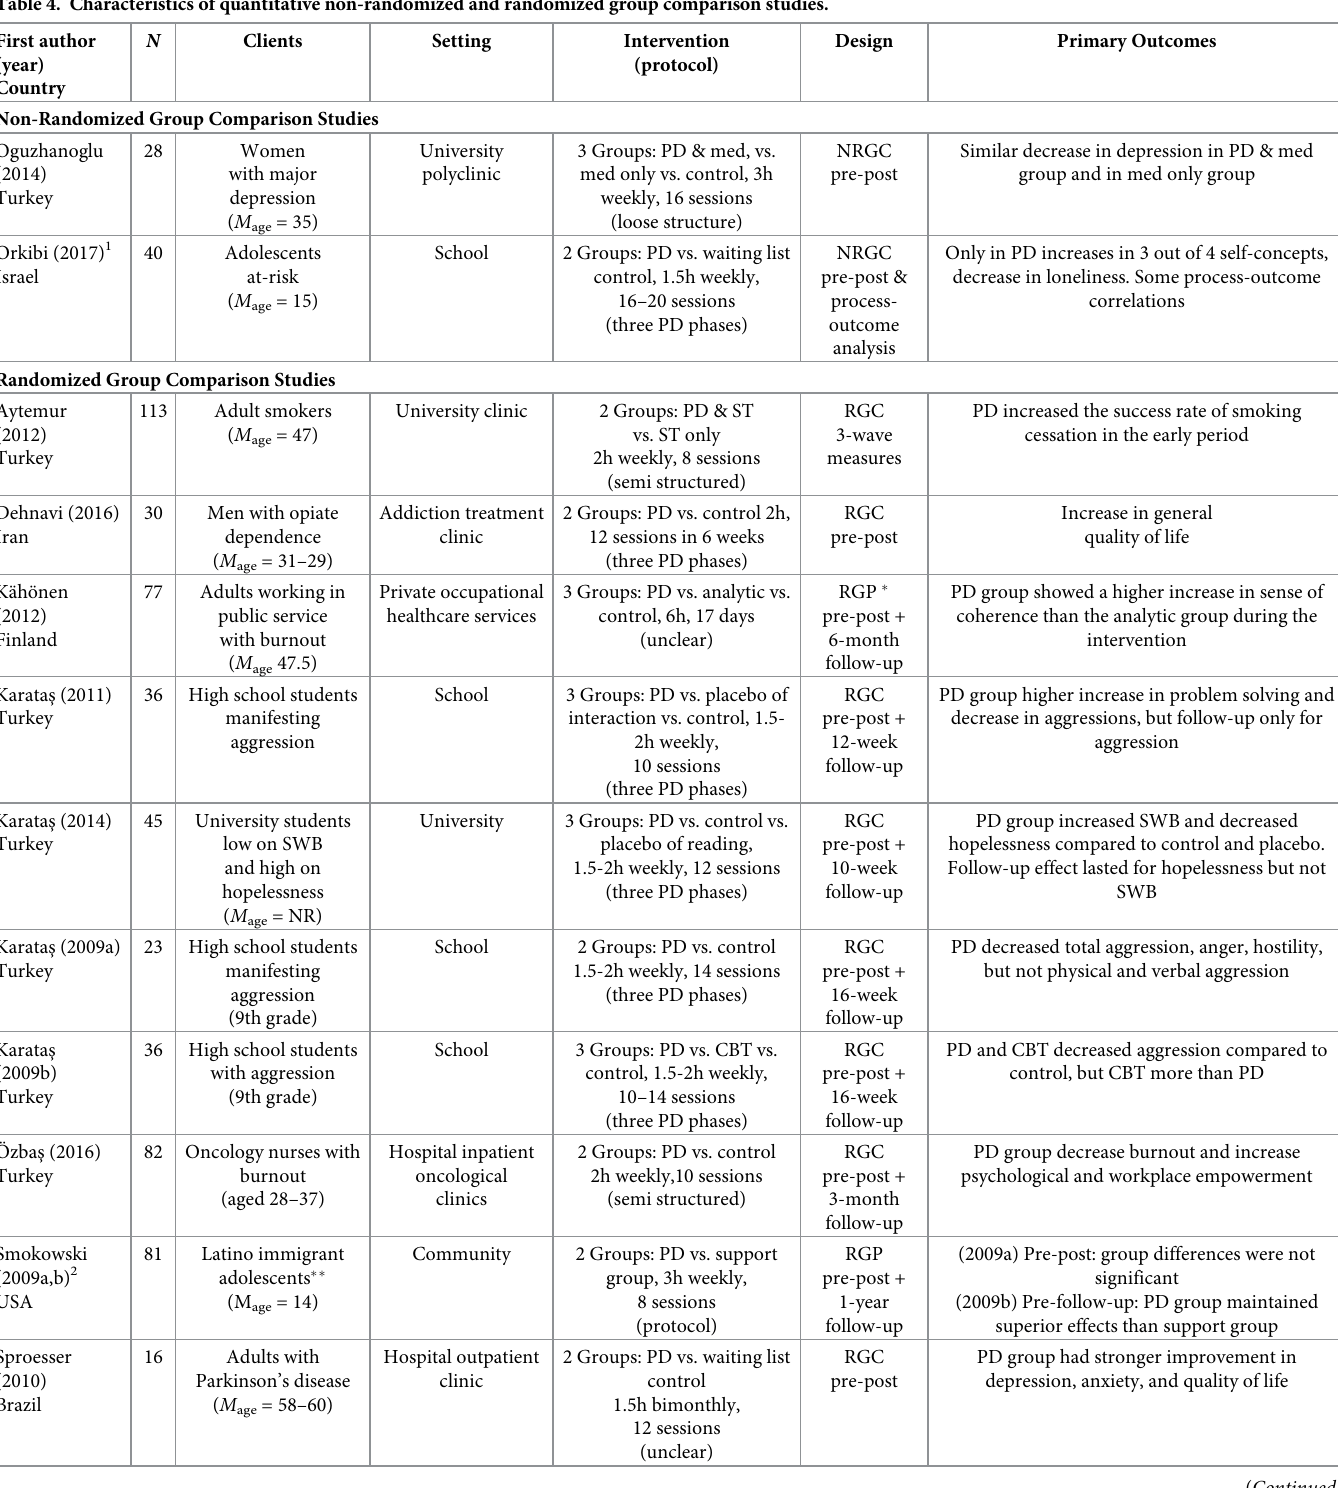
Table 4. Characteristics of quantitative non-randomized and randomized group comparison